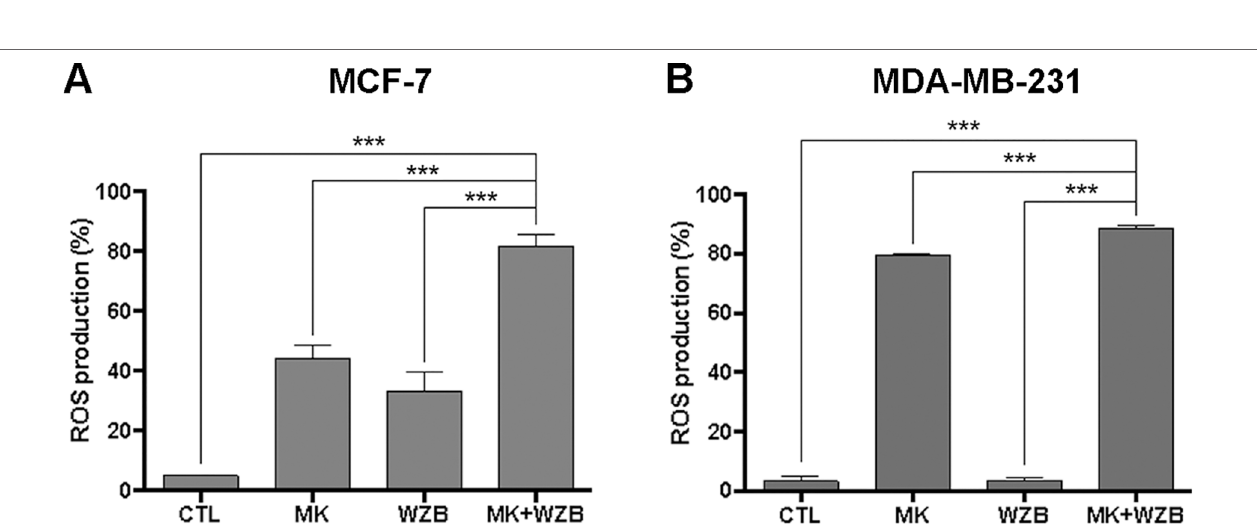
FIGURE 8 | MK-2206 and WZB117 synergistically induce ROS in breast cancer cells. (A) Quantitative data of MCF-7 cells with ROS production. Cells were treated with 3 μM MK-2206 and 30 μM WZB117 either alone or in combination along with 10 μM DCFH-DA for 30 min. (B) Quantitative data of MDA-MB-231 cells with ROS production. Cells were treated with 6 μM MK-2206 and 30 μM WZB117 either alone or in combination along with 10 μM DCFH-DA for 30 min. DCFH-DA is non-fluorescent and is hydrolyzed by intracellular esterases to 2,7-dichlorodihydrofluorescein, which is then oxidized to fluorescent 2,7-dichlorofluorescein (DCF) by ROS. DCF fluorescence was detected by flow cytometric analysis and 10,000 cells were counted. The percentage of cells with ROS production was indicated. Data are presented as the mean ± SEM of at least three independent experiments. *** P < 0.001.